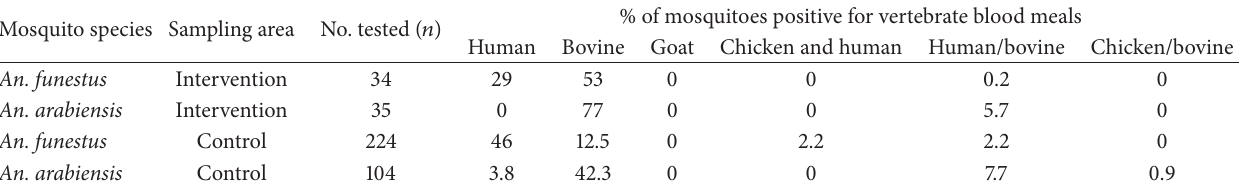
Table 3: Blood meal origin of indoor collected Anopheles